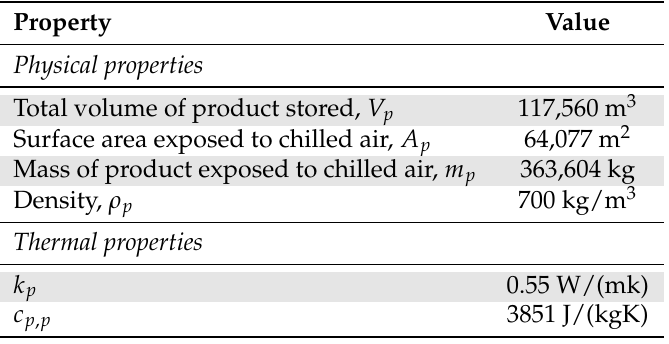
Table 2. Physical and thermal properties of the refrigerated